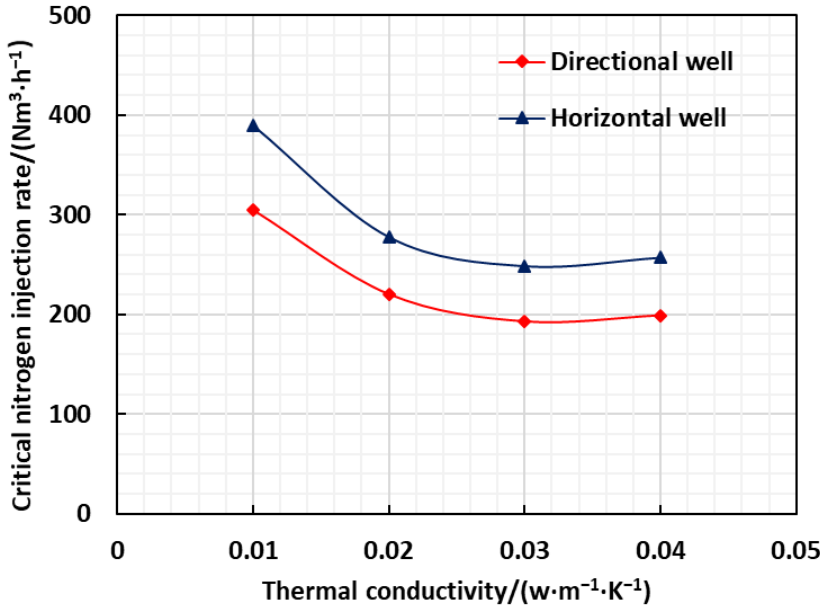
Figure 5. Relationship between thermal conductivity of heat insulation pipe and critical nitrogen injection displacement.